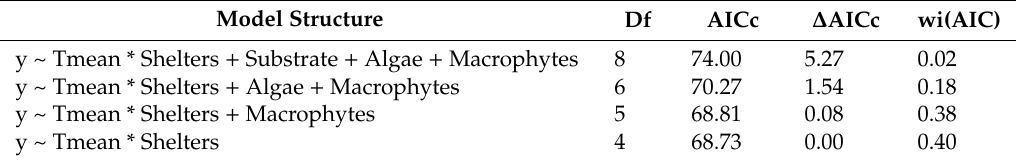
Table 3. Model selection according to the corrected Akaike information criterion for finite sample size (AICc [35]). Model are ordered from the least to the most appropriate. df: degrees of freedom, ∆